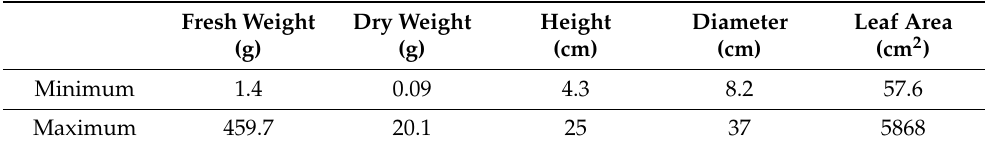
Table 2. Maximum and minimum values for each growth index within the dataset measured using destructive methods.